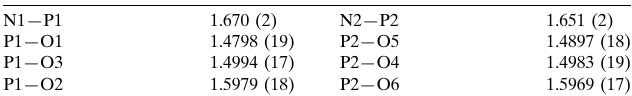
Selected bond lengths (A˚ ).